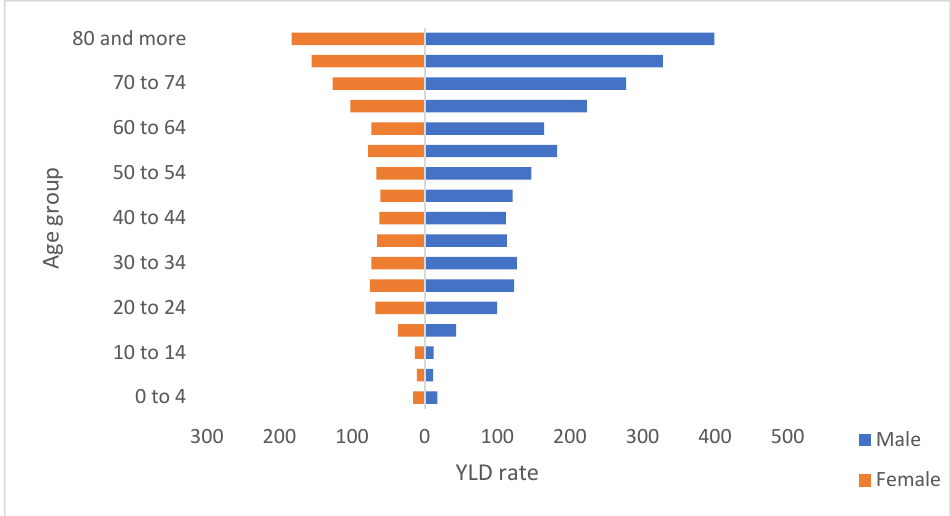
Figure 2. YLD rate by sex an age groups, Colombia, 2010–2018. 3.3. Disability-Adjusted Life Years (DALYs) or Healthy Life Years Lost to TB The sum of the years of life lost due to premature mortality and the years lived in suboptimal health states, generated by TB constitute the burden of disease for this event in Colombia. The rate of the study period was 684 (95% CI 581.2–809.1) per 100,000 inhabitants. The years with the highest rate were 2010 (84.3 95% CI 72.1–100.5) and 2018 (81.4 95% CI 63–100). According to sex, 68.4% occurred in men; for each DALY in women, 2.21 were present in men (Table A1). The differences between the sexes became smaller in the older age groups. By age group, people of productive age (15 to 69 years) comprise 56% (Figure 3).